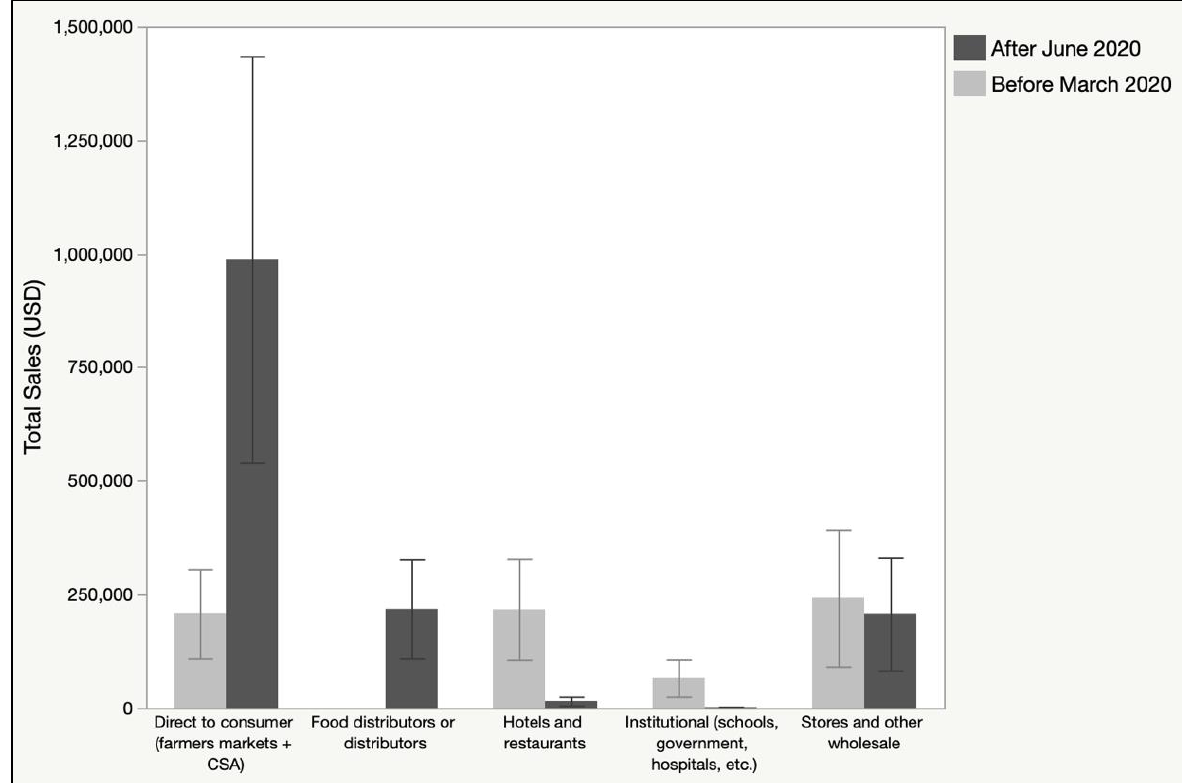
Figure 2. Shifts in Total Sales Outlets and the Standard Error Bars for Seven Food Hubs that Contributed Their Sales